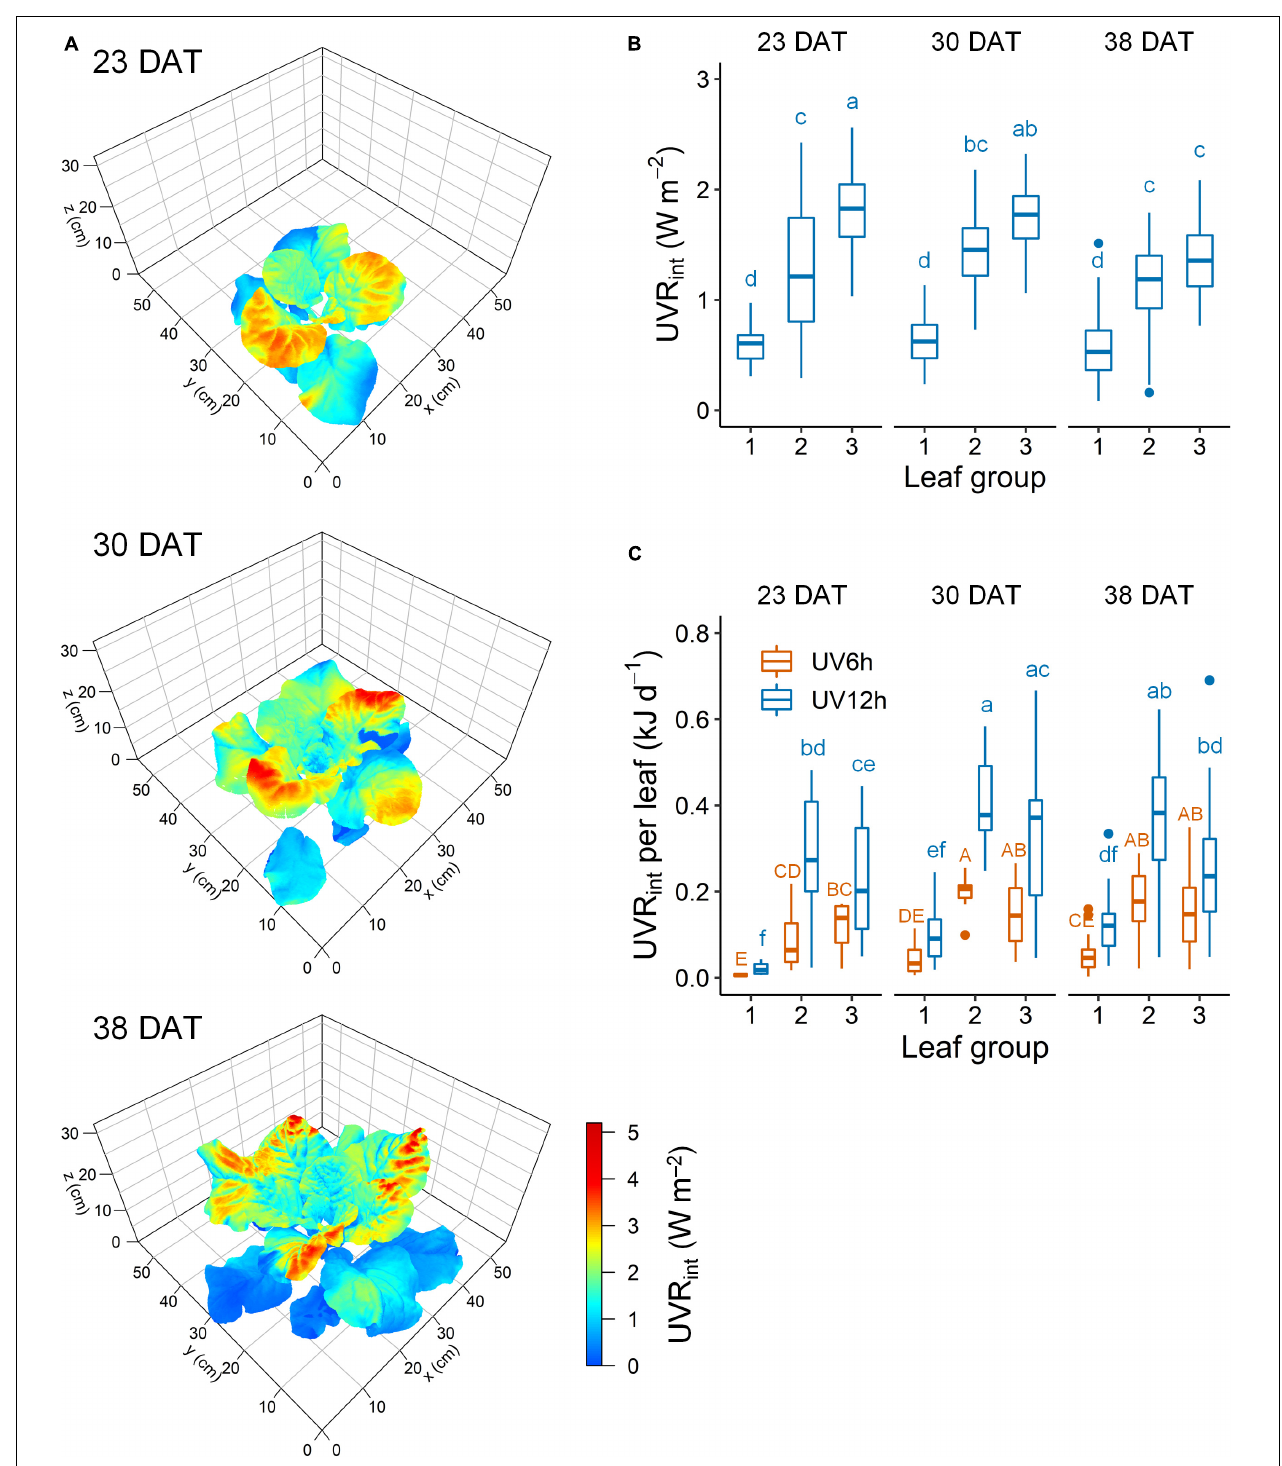
FIGURE 3 | Representative simulated UV-B radiation interception (UVR int ) on 3D-scanned models (A) , mean UVR int (B) , and daily UVR int per leaf (C) of kale plants according to UV-B radiation and leaf group at 23, 30, and 38 days after transplanting (DAT). Leaf groups were determined according to the order of leaf emergence and their relative growth state ( Supplementary Figure 3 and Supplementary Table 1 ). Different letters indicate significant differences at P < 0.05 for UVR int value ( n = 26–47) and daily UVR int per leaf ( n = 11–25) with growth stage and leaf group by two-way ANOVA and Tukey’s HSD test.